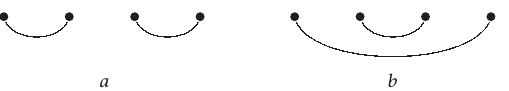
Figure 1: Crossingless matches a and b for r (cid:8) 2.